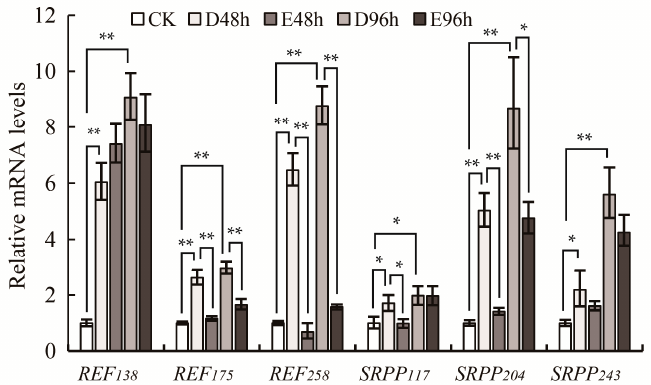
Figure 4. The expression patterns of REF and SRPP in the latex of rubber tree clone RY 7-33-97. The relative expression levels of the six REF and SRPP genes were normalized to HbActin . CK (control check), latex from the first tapping; D48h, D96h, latex harvested 48 and 96 h after tapping, distilled water treatment; E48h, E96h, latex harvested 48 and 96 h after tapping, ethylene treatment. Data from qRT-PCR contains three biological repeats and the error bars indicate the standard deviations. Above an error bar, the symbol * indicates a difference of p < 0.05 (Student’s t -test), and the symbol ** indicates a difference of p < 0.01 (Student’s t -test); D48h and D96h were compared to CK, and E48h and E96h were respectively compared to D48h and D96h.